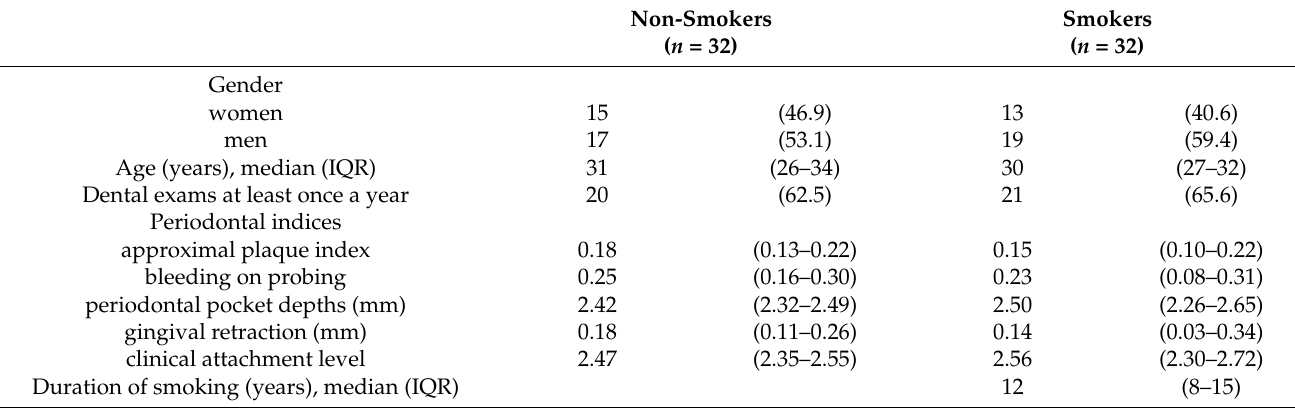
Table 1. Participants’ sociodemographic and clinical